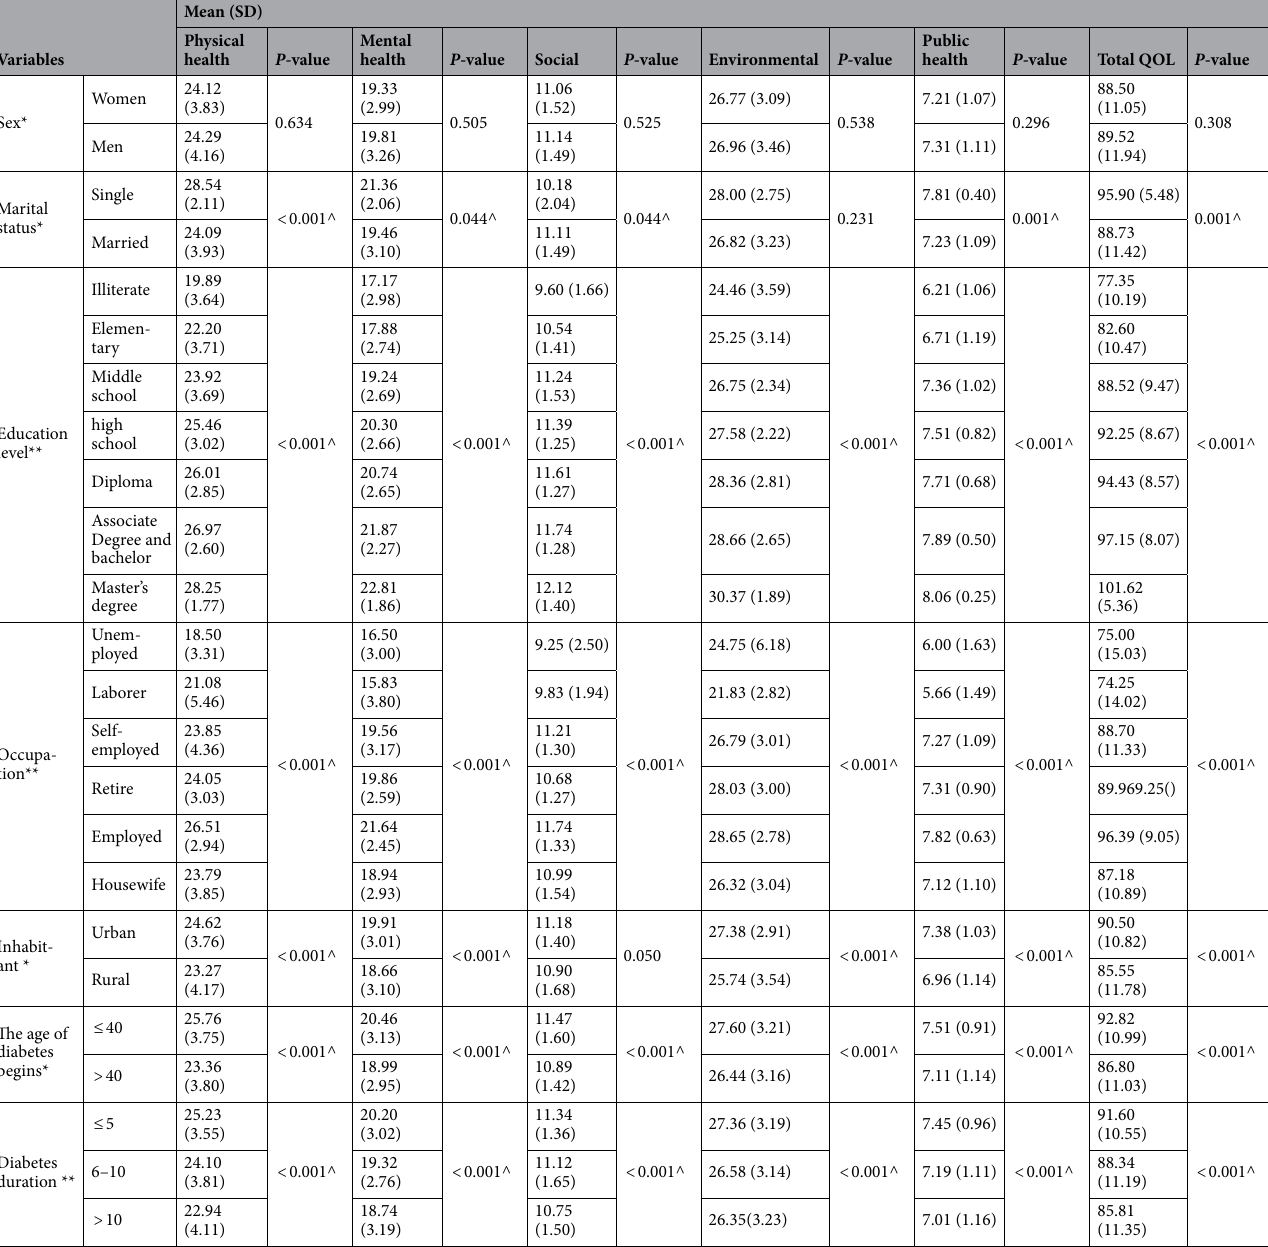
Table 4. Relationship between demographic variables and quality of life (QOL). * Independents sample T-test, **One- Way ANOVA, ^ significance level <